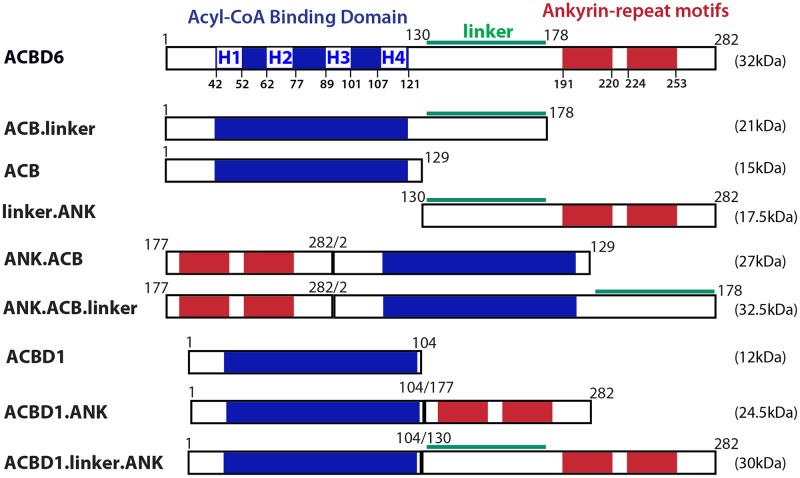
Cartoon representation of the constructs used in this study.The 4 α-helix (H1 to H4) of the acyl-CoA binding domain (blue), of the linker region (green), and of the two ankyrin-repeat motifs (red) of human ACBD6 (282 residues) are shown. For clarity, the different constructs are designed by the presence of the 3 regions: ACB domain (residues 1 to 129), linker (130 to 178), and ANK motifs (177 to 282). All constructs were produced with a hexahistidine tag at their carboxyl-terminal end and the calculated mass (kDa) of each protein is shown on the right. ACBD1 refers to isoform 1 of the product of the DBI gene.